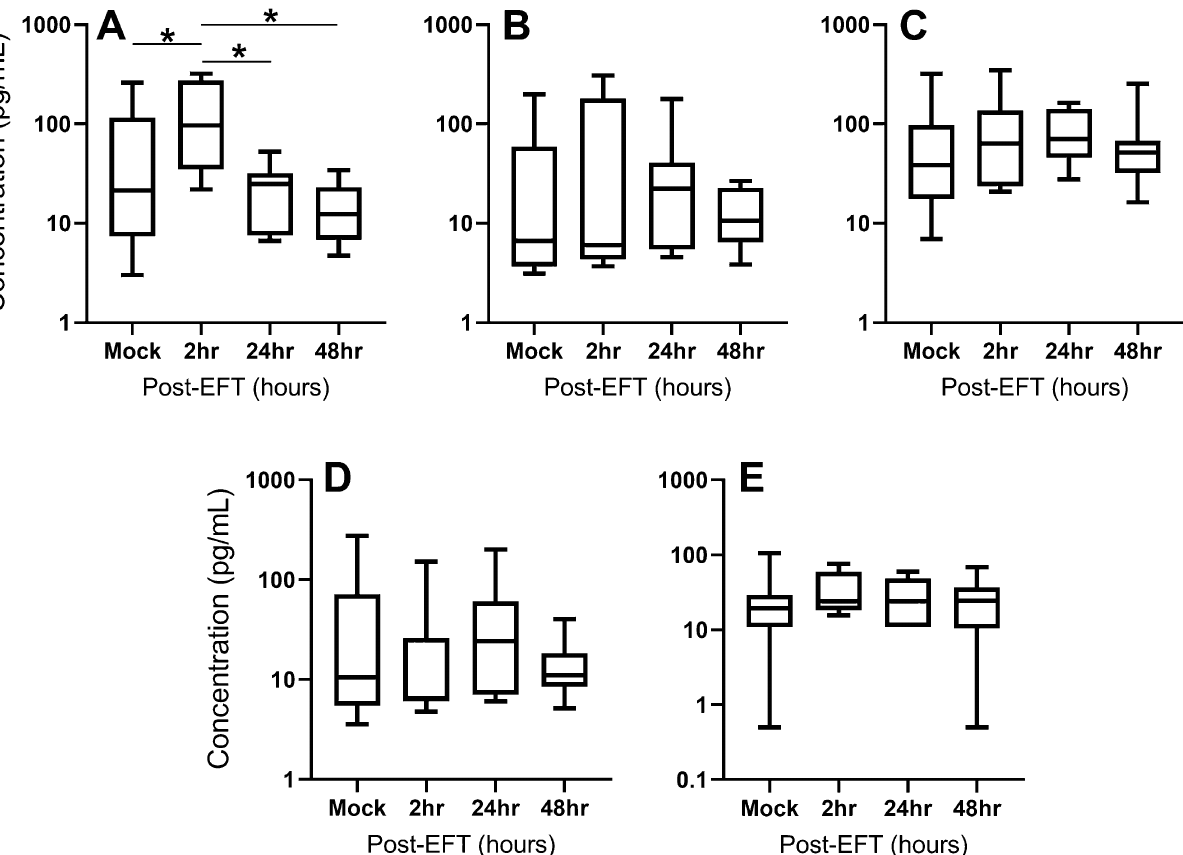
Figure 2. Inflammatory cytokine analysis of EFT and mock-treated naïve mice. After treatment as in Fig. 1, cytokines were measured in lung homogenates at each time point by bead-based multiplex. Cytokine levels for ( A ) IL-6, ( B ) IL-10, ( C ) IL-1β, ( D ) IFN-γ, and ( E ) GM-CSF are shown. Data are n = 7–13 for each group at each time point. Boxes are median line with first and third quartiles, min/max shown with brackets. * p < 0.05 by